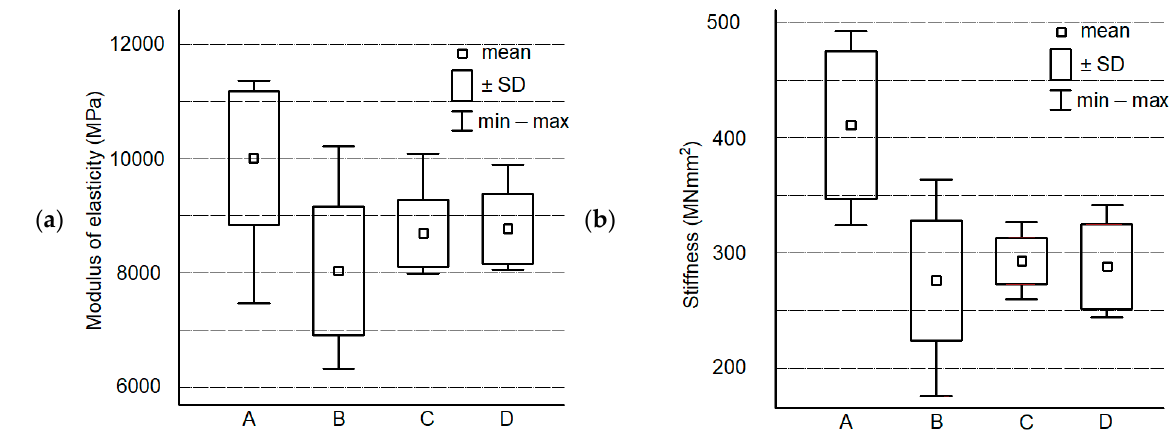
Figure 6. Results of dynamic bending after air conditioning under conditions of 22 °C and 50% air humidity: ( a ) MOE; ( b ) stiffness.